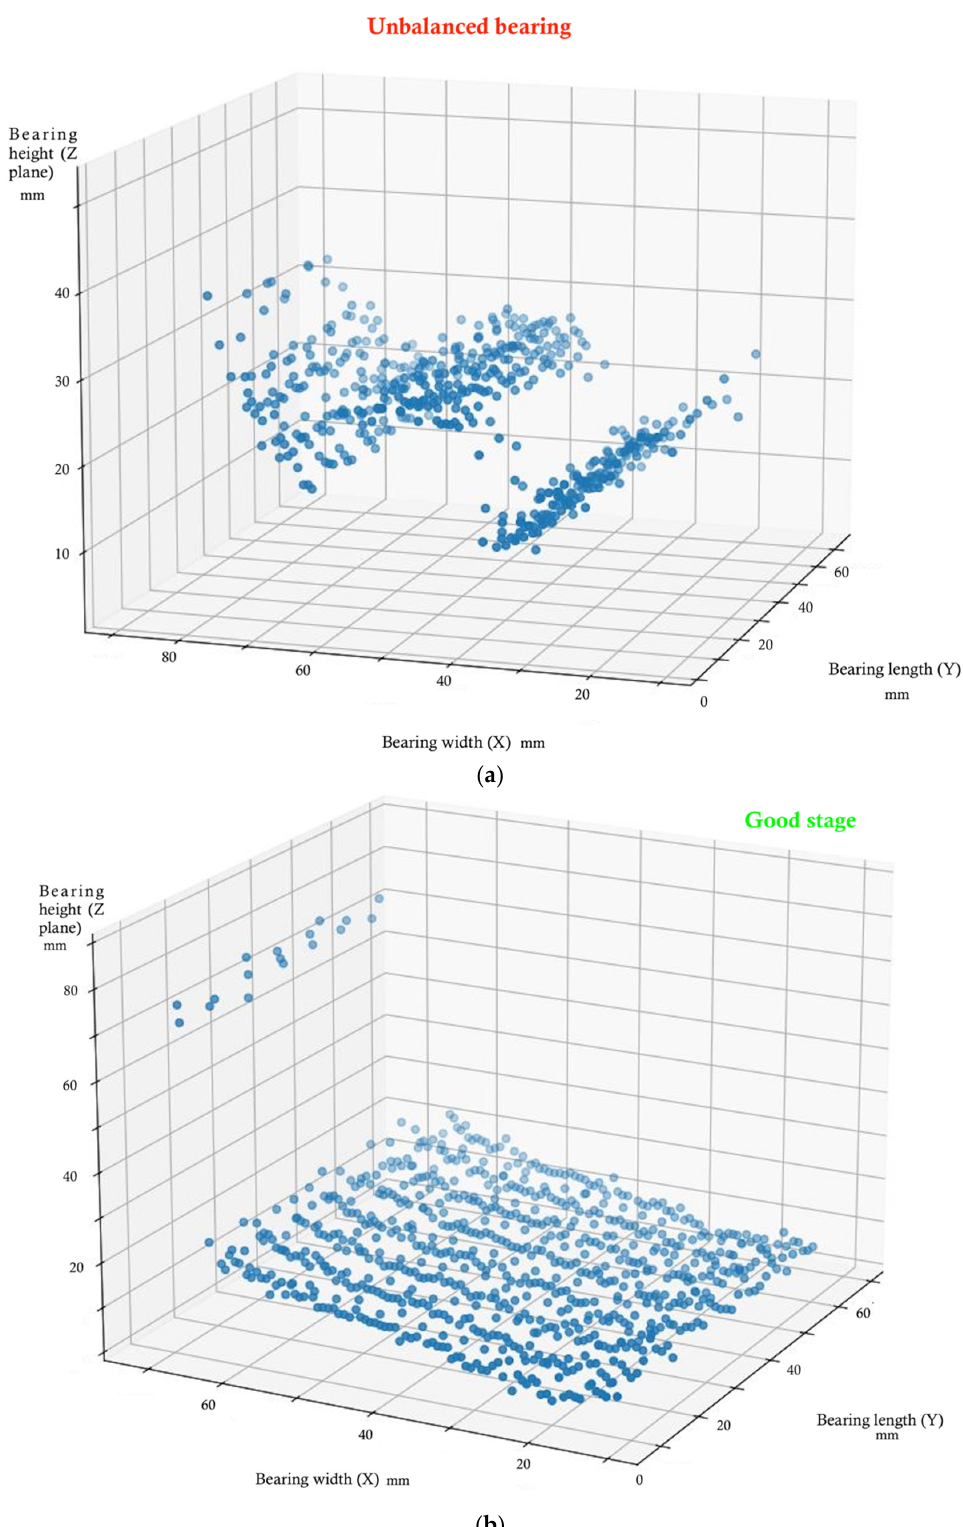
Figure 6. ( a ). Imbalance. Predicted output algorithm; ( b ). Good stage. Predicted output algorithm.